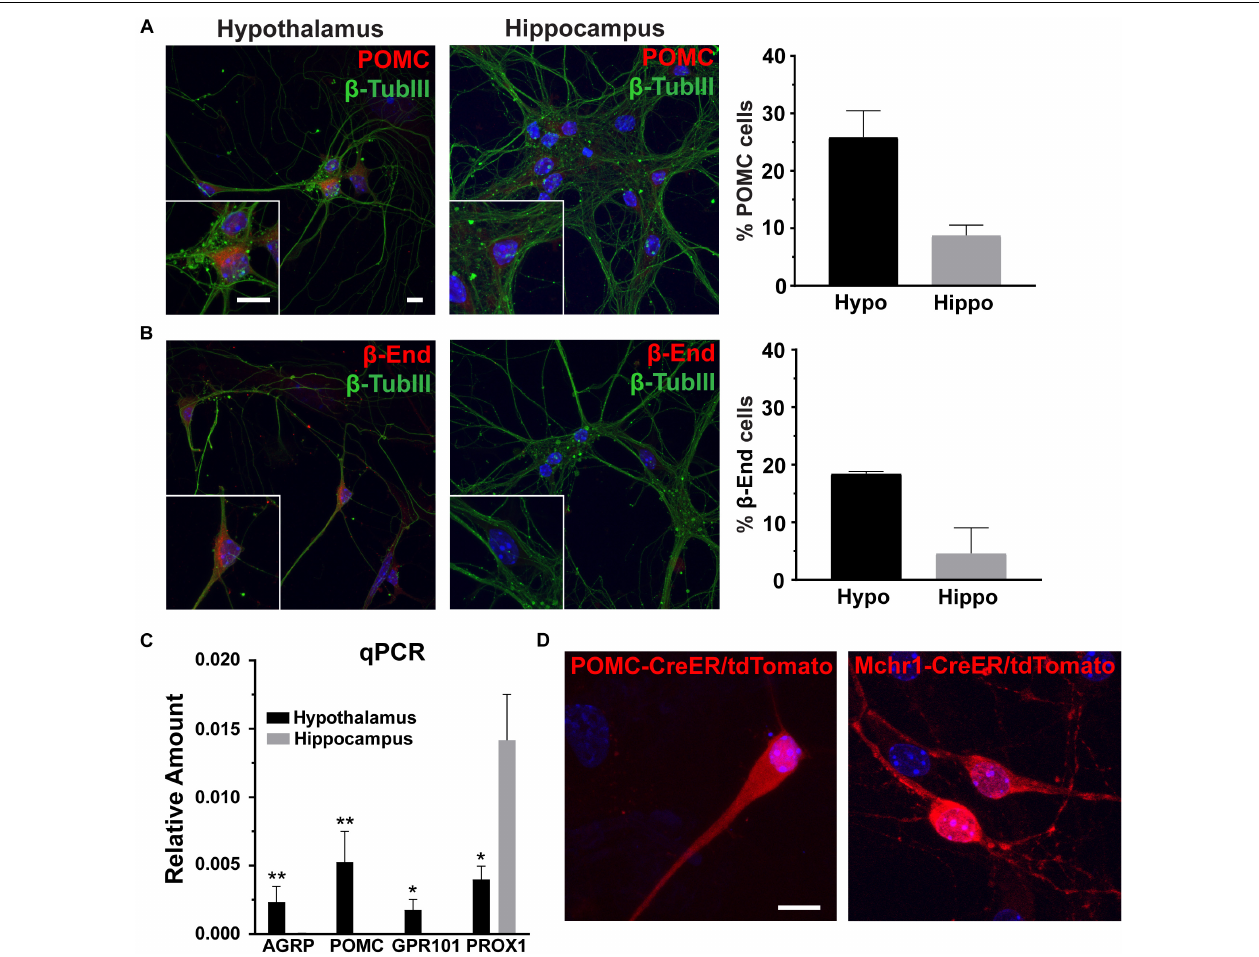
FIGURE 2 | Hypothalamic characteristics in vitro. (A) Proopiomelanocortin (POMC, red) and (B) β -endorphin ( β -End, red) staining in hippocampal and hypothalamic cultures co-stained for β -tubulin III ( β -TubIII, green). Scale bars are 10 µ m. Percentage of cells positive for POMC or β -endorphin divided by the total number of cells counted in the hypothalamus and hippocampus graphed as mean ± SEM. Data collected from 3 hypothalamic and hippocampal samples from 3 experimental days. POMC positive cells/total hypothalamic nuclei: 166/642, β -endorphin positive cells/total hypothalamic nuclei: 203/657, POMC positive cells/total hippocampal nuclei: 57/653, and β -endorphin positive cells/total hippocampal nuclei: 69/678. (C) Quantitative PCR (qPCR) analysis on total RNA isolated from day 7 hypothalamic and hippocampal cultures. Gene expression of agouti related peptide (AgRP), POMC, G protein-coupled receptor 101 (GPR101), and Prospero homeobox protein 1 (PROX1) relative to actin is graphed as mean ± SEM. ∗ P < 0.05 and ∗∗ P < 0.01 using a Students t -test. Data collected from 7 hypothalamic and hippocampal samples from 3 experimental days. (D) Neurons cultured from mice with hypothalamic inducible cre alleles (POMC-CreER and Mchr1-CreER) show the presence